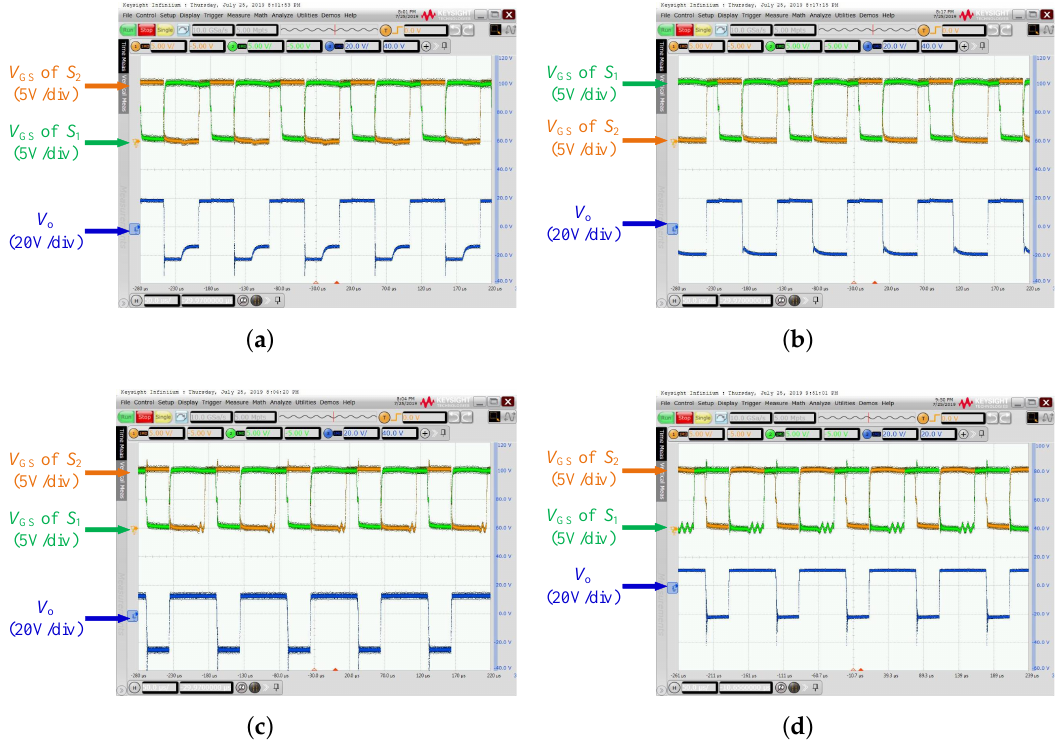
Figure 9. Experimental waveforms of the proposed converter in: ( a ) turns ratio 3:1:5, duty ratio D 1 = 0.5, D 2 = 0.66; ( b ) turns ratio 1:3:5, duty ratio D 1 = 0.5, D 2 = 0.66; ( c ) turns ratio 3:1:5, duty ratio D 1 = 0.66, D 2 = 0.5; ( d ) turns ratio 1:3:5, duty ratio D 1 = 0.66, D 2 =